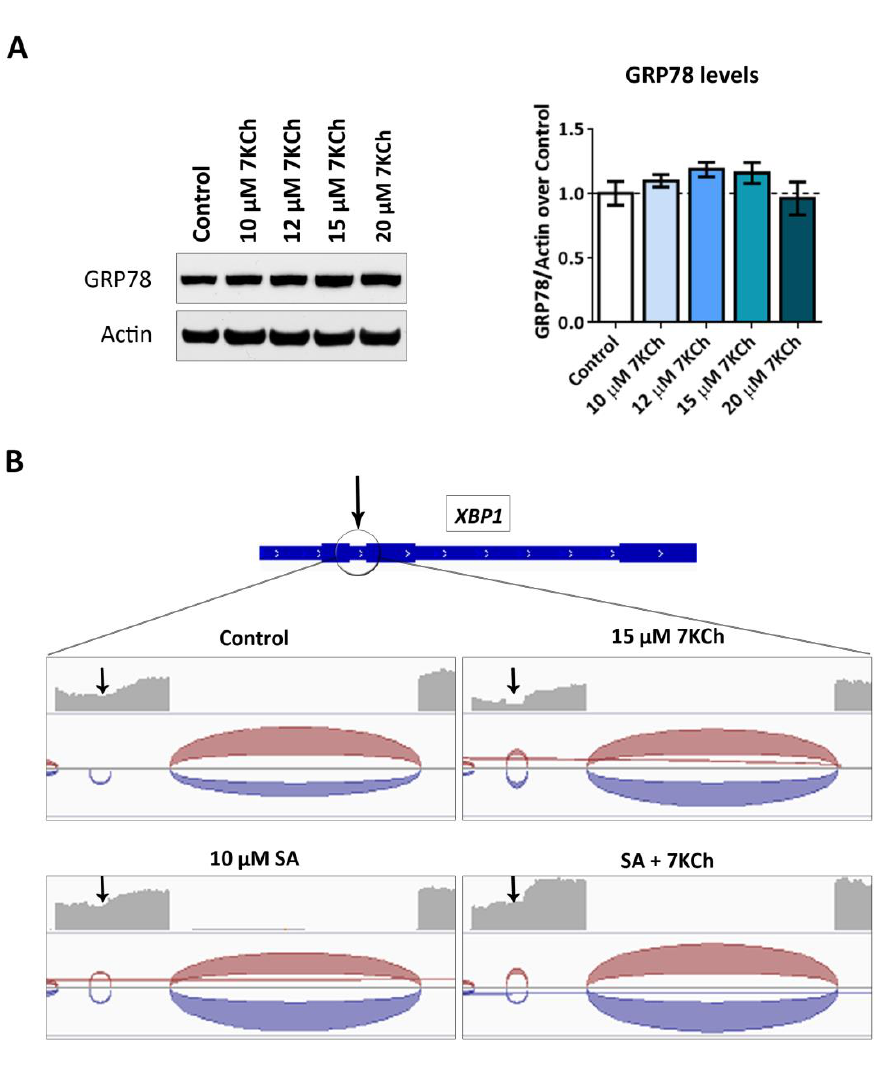
Figure 6. UPR signaling induced in response to 7KCh in mRPE cells. ( A ) Western blot estimation of GRP78 levels in mRPE cells exposed to increasing concentrations of 7KCh for 24 h. GRP78 levels were normalized with respect to Actin band quantification. Data are represented as mean ±SEM of at least three different experiments. The dashed line is a guidance of the control value. ANOVA test was used for statistical analysis followed by Tukey post hoc test. ( B ) XBP1 splicing detection in the RNAseq analysis in mRPE cells treated with 15 μM 7KCh and/or 10 μM SA. Distribution of reads on XBP1 was visualized using the software IGV (Integrated Genome Viewer). Black arrows indicate the position in which the splicing was performed.